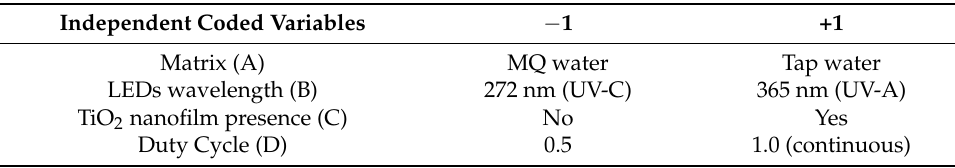
Table 1. Independent coded variables corresponding to the first DoE. Independent Coded